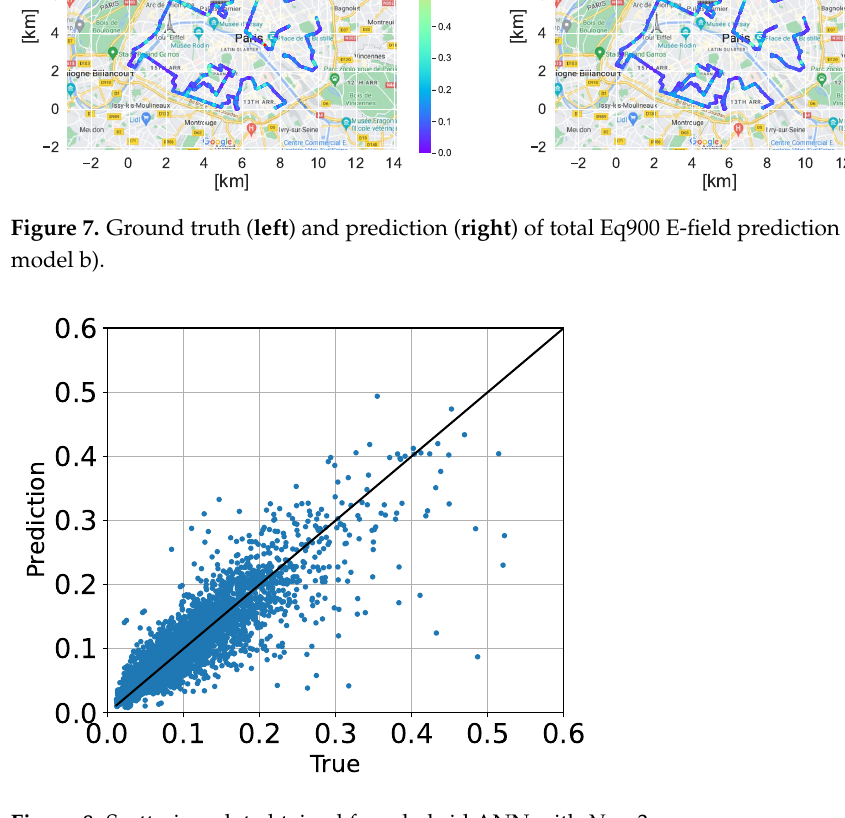
Figure 8. Scattering plot obtained from hybrid ANN with N =